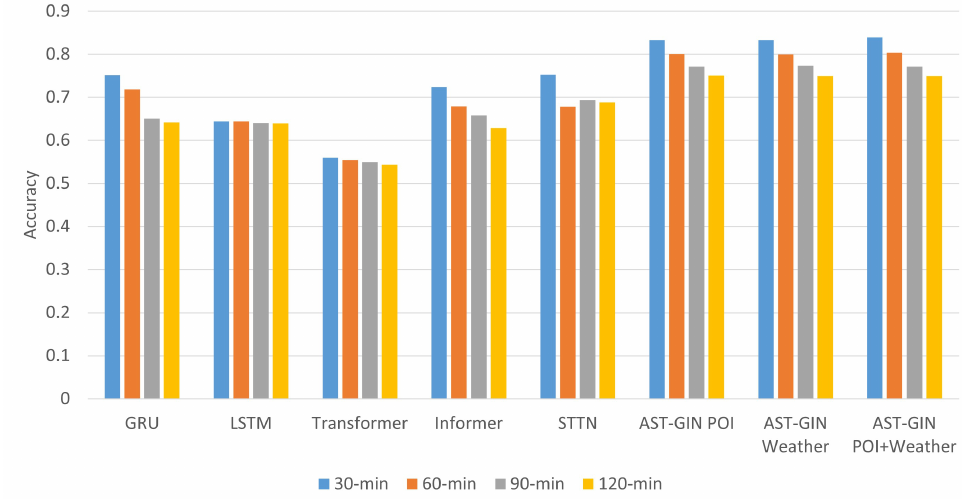
Figure 7. Accuracy statistics of all